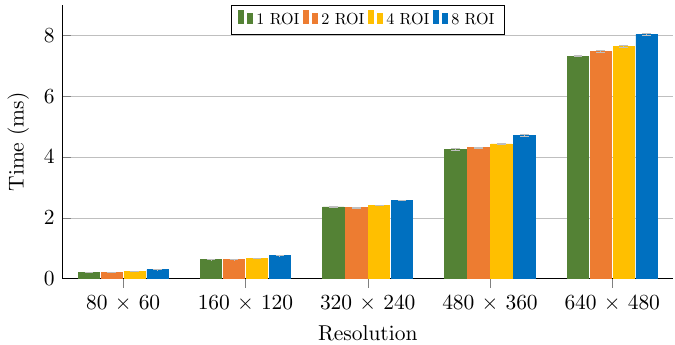
Figure 16. Operations applied to identify Regions-of-Interest (ROIs).